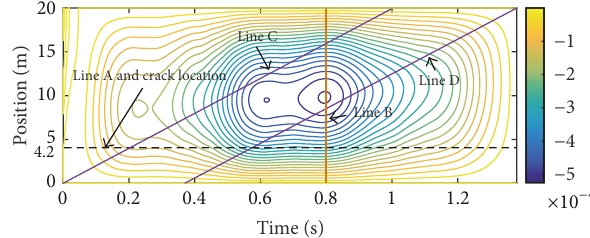
Figure 3: Contour plot of deflections (in m) for the damaged bridge for single damage scenario in Figure